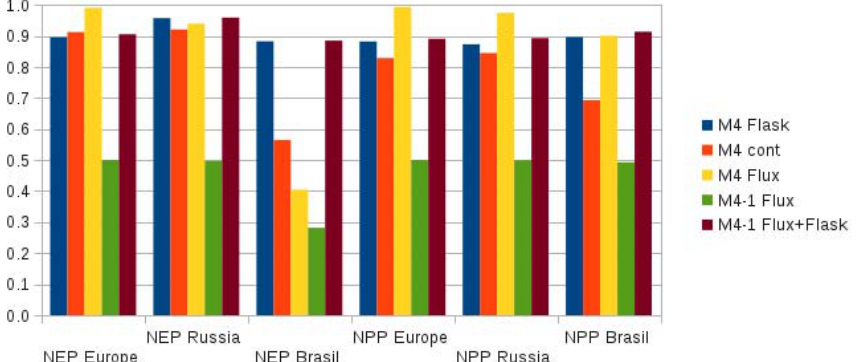
Fig. 8. Evaluation for multiplicity 4 of three base networks, an incomplete flux network with one copy of each PFT unsampled, and the combination of the incomplete flux network with the flask